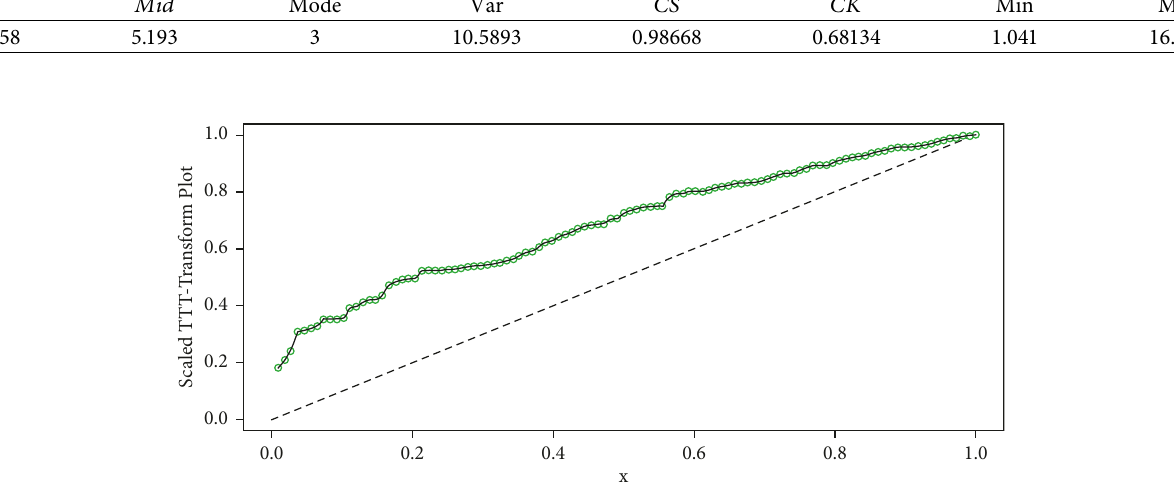
Figure 13: The TTT Plot of the COVID-19 fatality rate